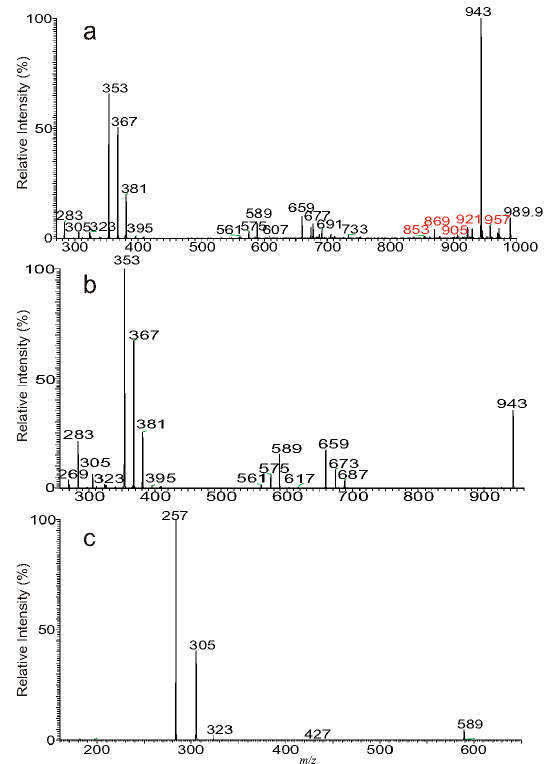
Figure 6. The negative-ion MS 2 spectrum of the [M + HCO 2 ] − ions of DAT at m/z 989 ( a ), its MS 3 spectrum of the ions of m/z 943 (989 → 943) ( b ), MS 4 spectrum of the ions of m/z 589 (989 → 943 → 589) ( c ). The ions of m/z 989 are minor species and its MS 2 spectrum contains several ions (shown in red in (a)) unrelated to the structure, but have been filtrated from higher stage MS n , as shown in (b) (MS 3 ) and (c) (MS 4 ).